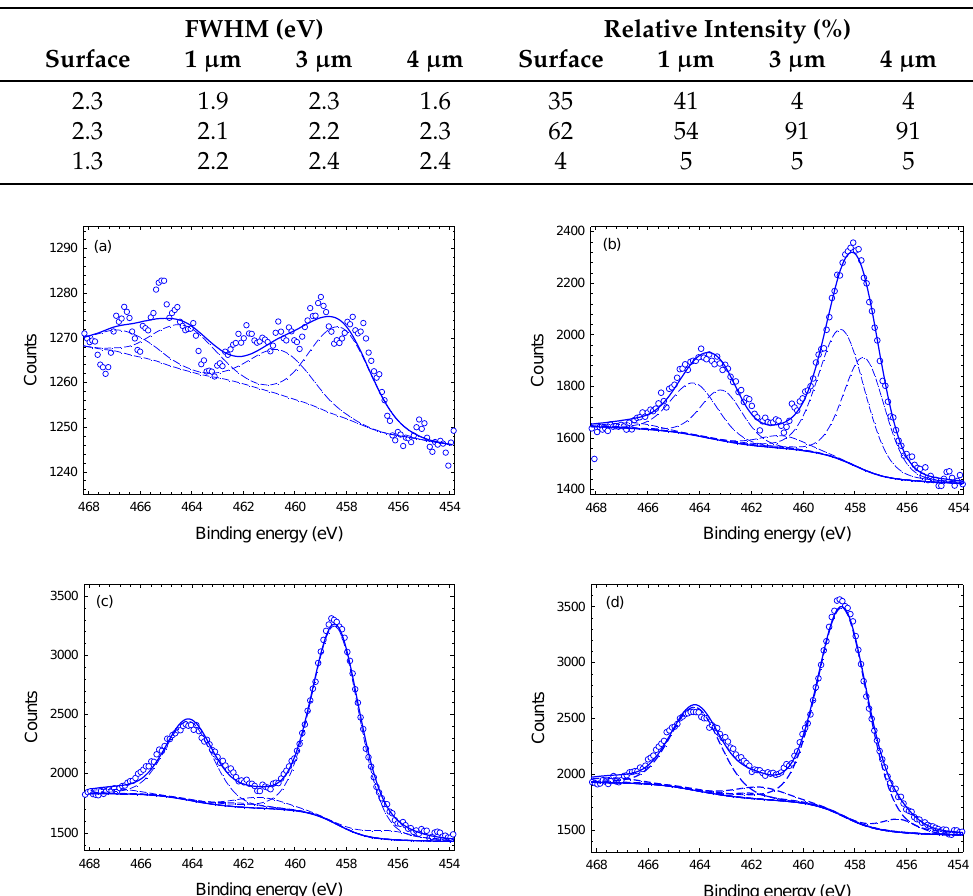
Table 2. Position, FWHM (full-width-at-half-maximum), and relative peak intensity of Ti-2p 3/2 XPS sub-peaks of the deposited Ti x -Cu y N z coating for different film depth.